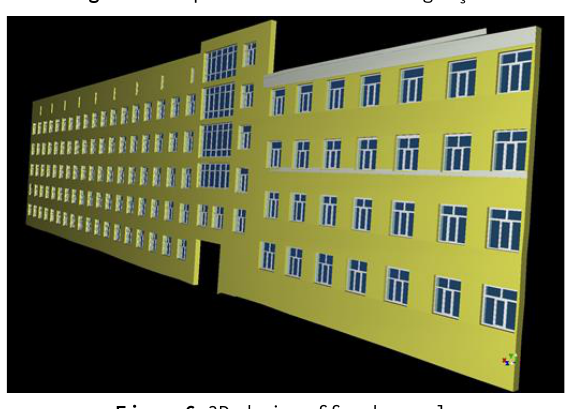
Figure 6 . 3D design of façade panels.